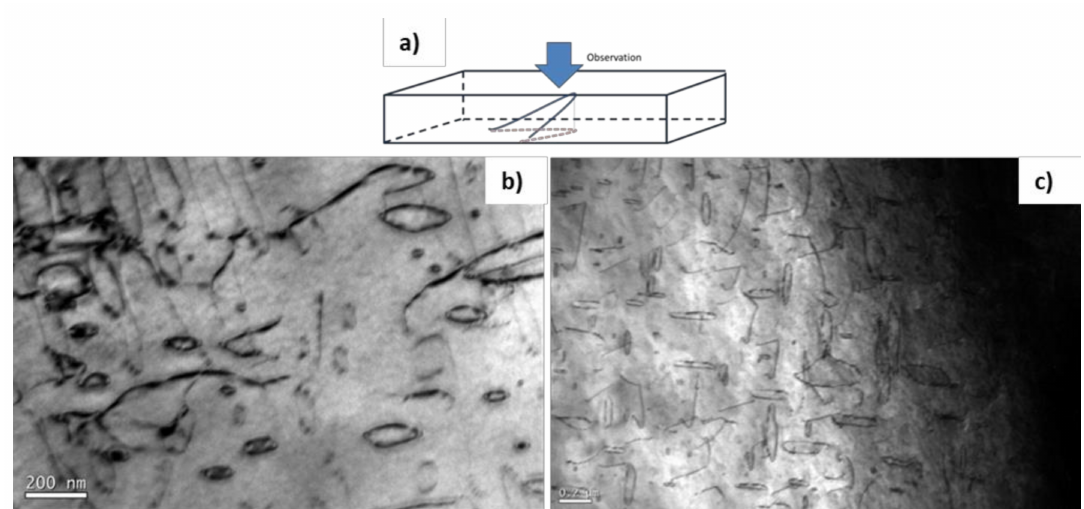
Figure 27. Schematic representation of an open loop ( a ) and TEM micrographs showing open loops distributed within the matrix found at different irradiation conditions ( b , c